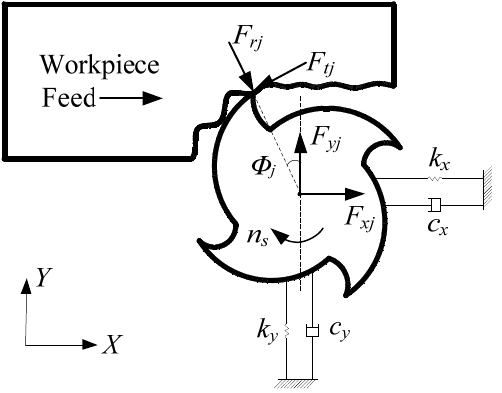
Figure 1. Model of milling system (down milling). Process damping is mainly generated by the indentation and friction between the flank face of the tool and the machined surface of the workpiece. The ploughing force is produced in the opposite direction of the vibration velocity. Figure 2 shows the interference phenomenon between the flank face of the tool and the machined surface.